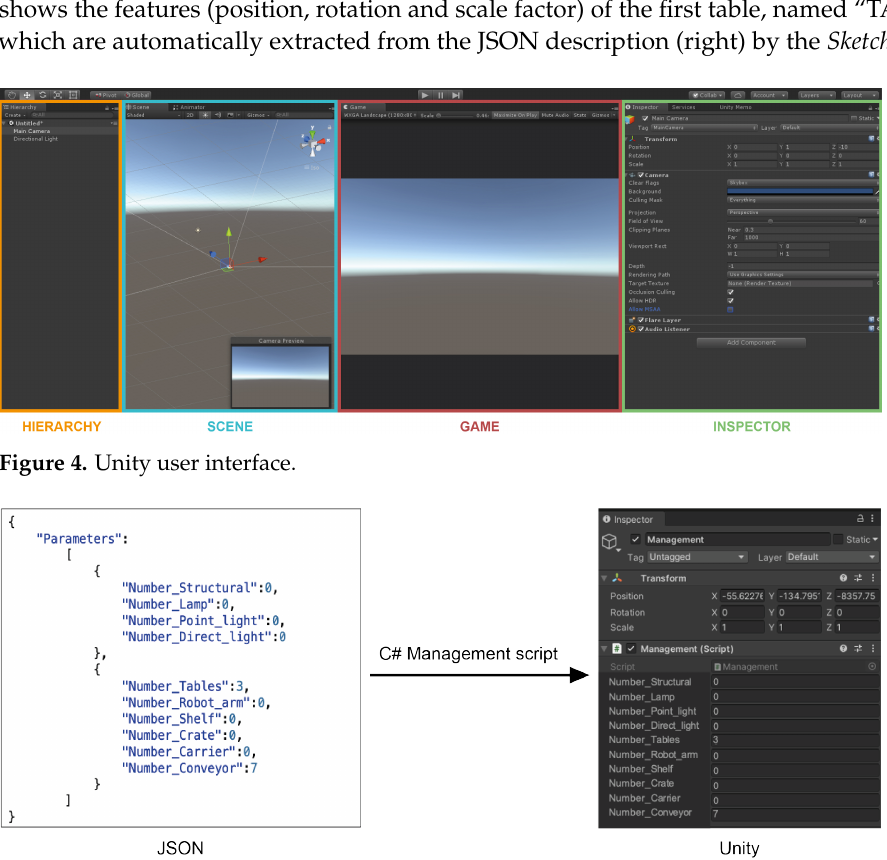
Figure 5. The number of elements in the desired scene is automatically extracted from the JSON description scene ( left ) and reported in Unity ( right ) through the Management script.